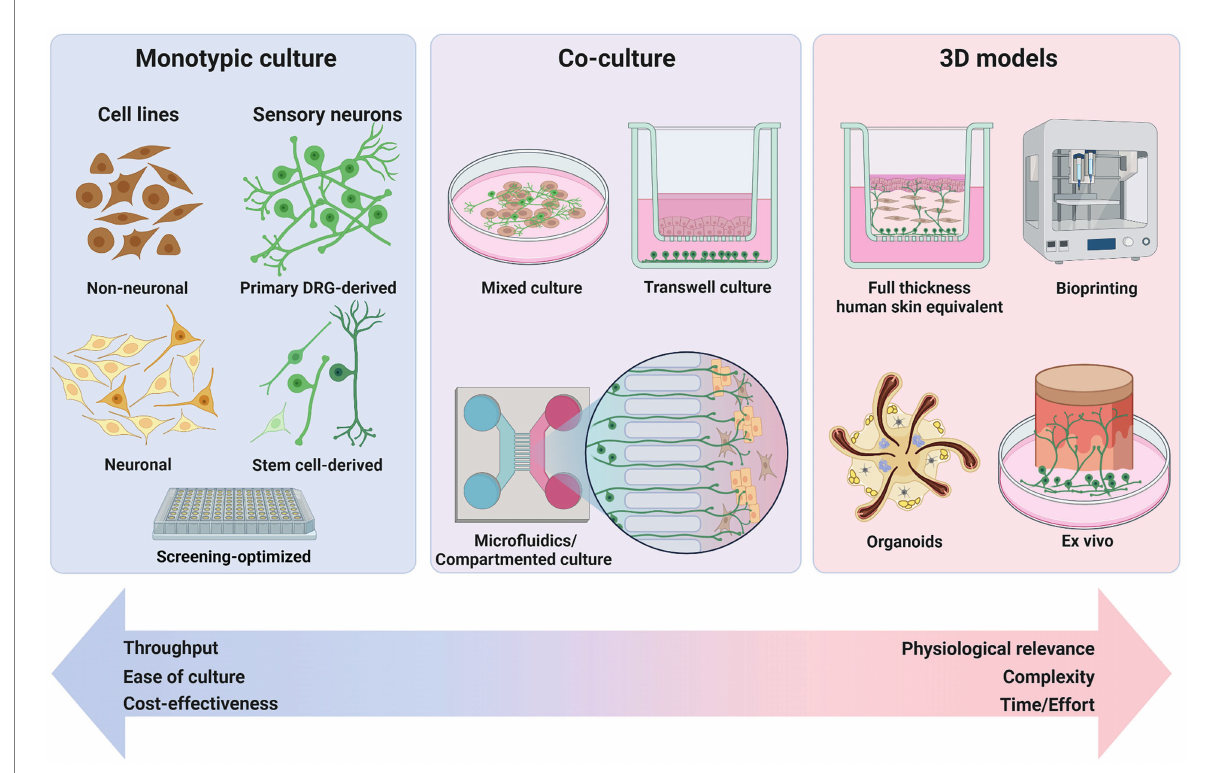
FIGURE 2 Types of in vitro models for investigating itch. From simplistic monotypic 2D cultures to more elaborate 3D setups, surrogate models have been developed for the depiction of mechanisms that characterize itch. Physiological relevance for translation to the human system increases with complexity of the models but comes at the cost of lower throughput, higher cost, and greater effort. Created with